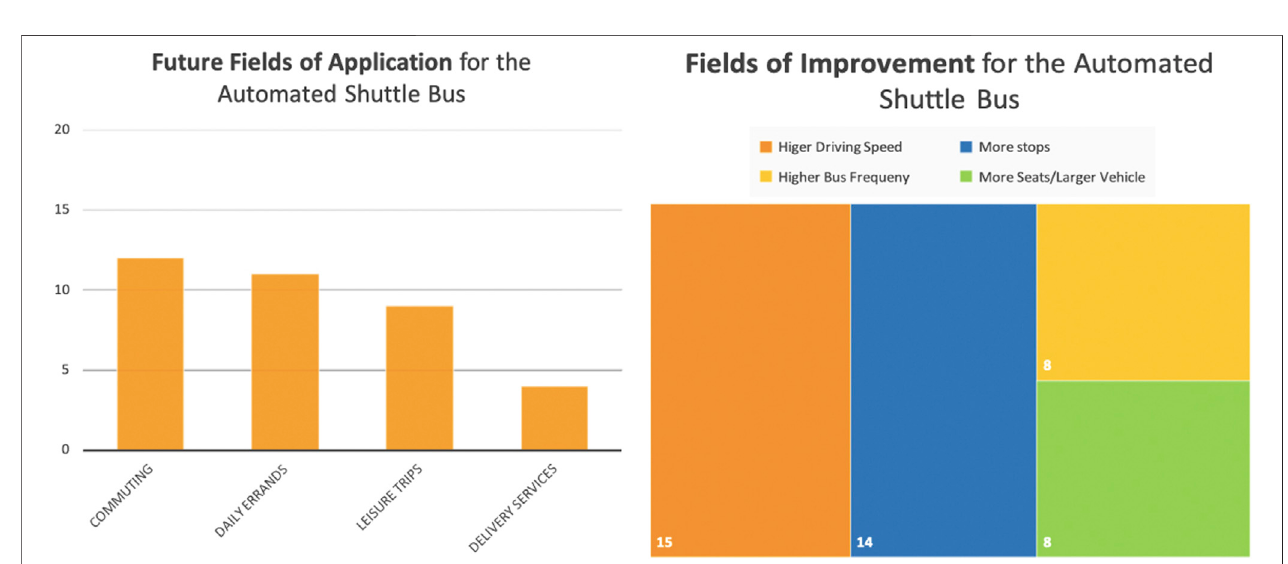
FIGURE 14 | Study 3: Responses regarding future fi elds of application for the automated shuttle bus.